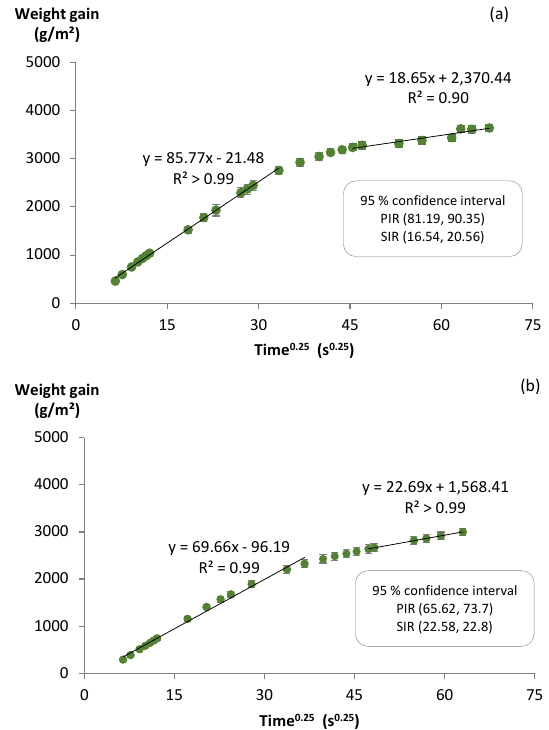
Figure 3. Capillary imbibition rate of Mix 2 at 28 (a) and 91 (b) days of age. The 95 % confidence intervals of the corresponding PIR and the SIR are given between